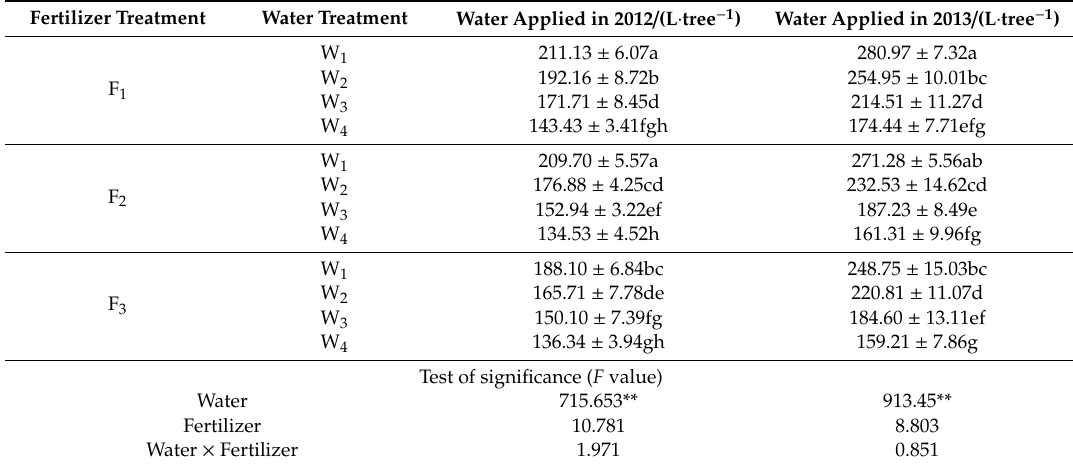
Table 1. The final value of water applied to each treatment of young apple trees in 2012 and 2013. Fertilizer